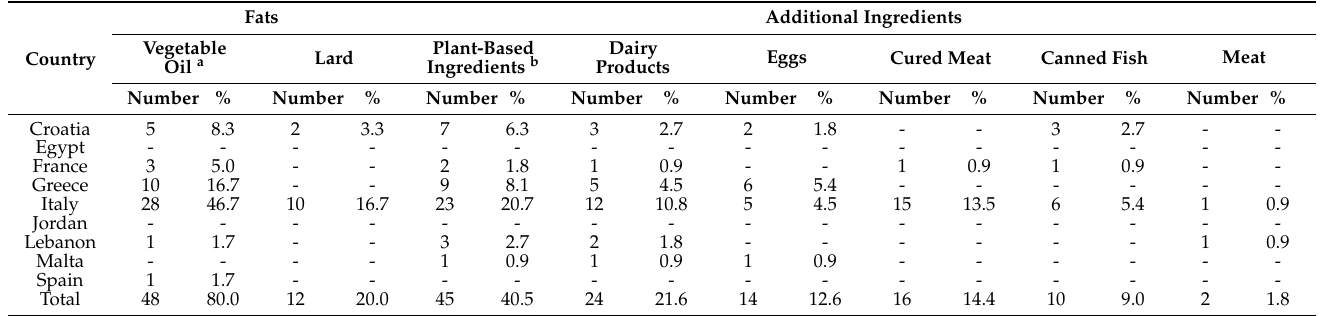
Table 4. Characteristic ingredients of garnished flat breads. Multiple answers were admitted, because breads could be prepared with different fats and ingredients.